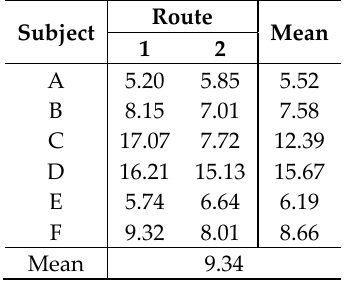
Table 1. Mean Absolute Error